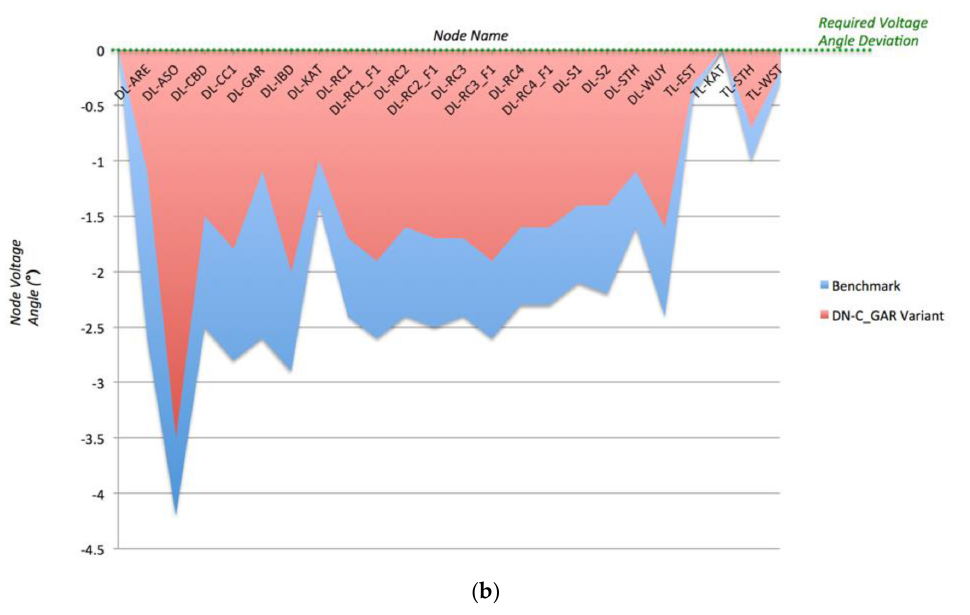
Figure 2. Graph indicating the effect of DN-C_GAR variant on ( a ) the voltage magnitude compensation; ( b ) the voltage angle deviation compensation. Table 3. Power Quality Performance of the Respective Benchmark Network Variants.